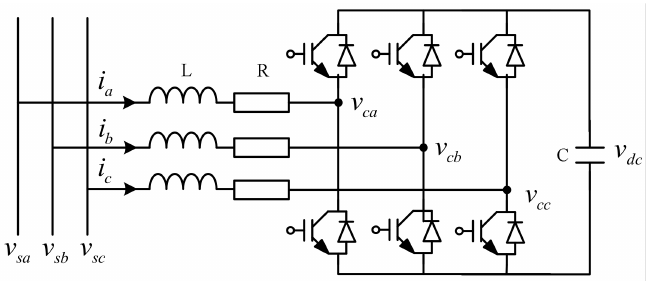
Figure 1. Schematic of a basic STATCOM